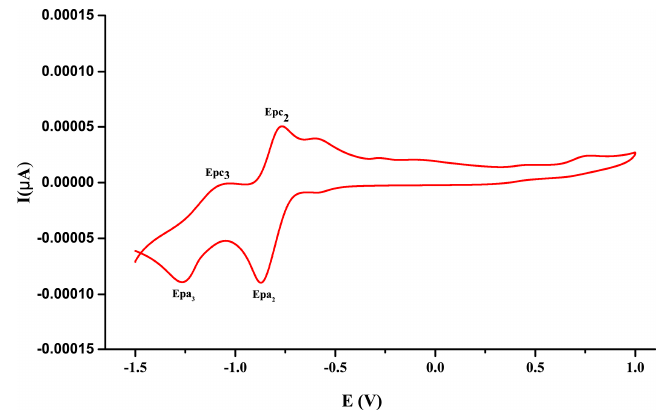
Figure 9. Cyclic voltammogram of the Co(II) complex in DMF at 298 K, c = 5 × 10 − 4 M, scan rate = 50 mV s − 1 .